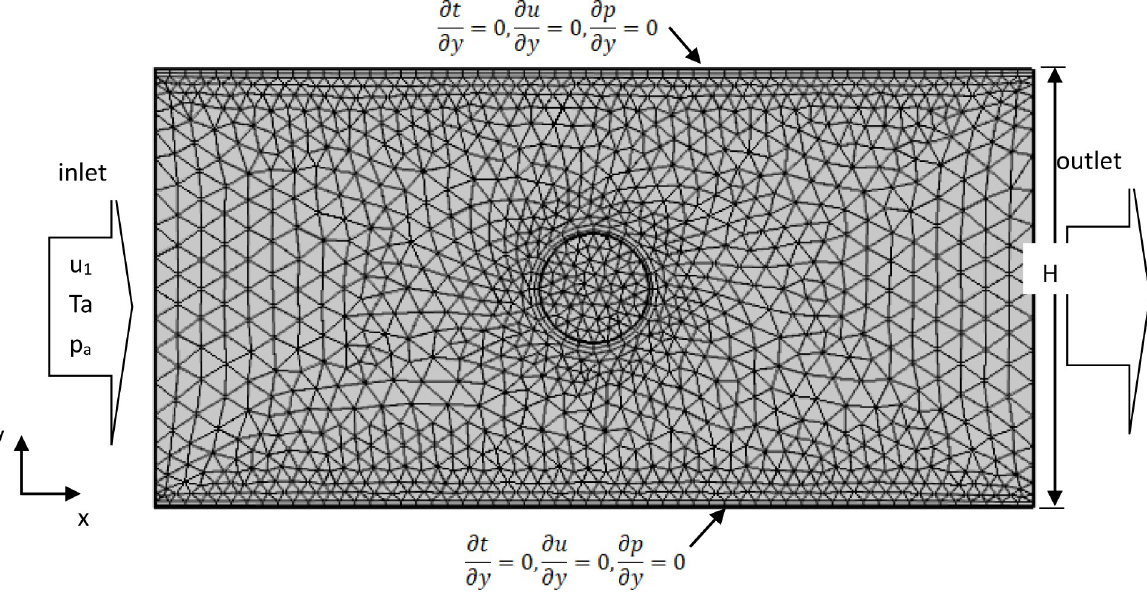
PLOS ONE | https://doi.org/10.1371/journal.pone.0277415 November17,